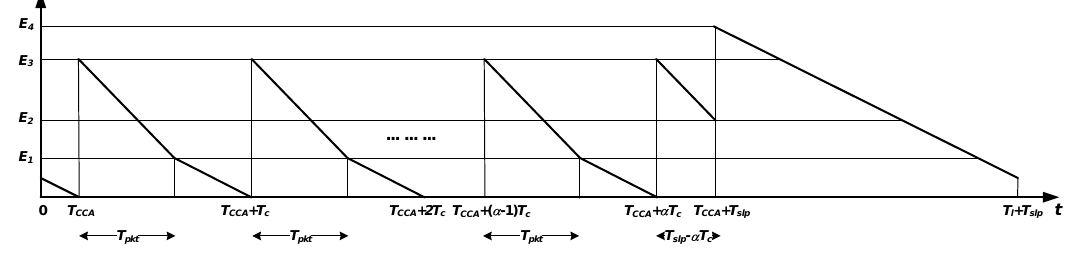
Figure 4. Evolution of E fd in terms of the transmitter-receiver asynchrony, for T slp ≤ α T c + T pkt .